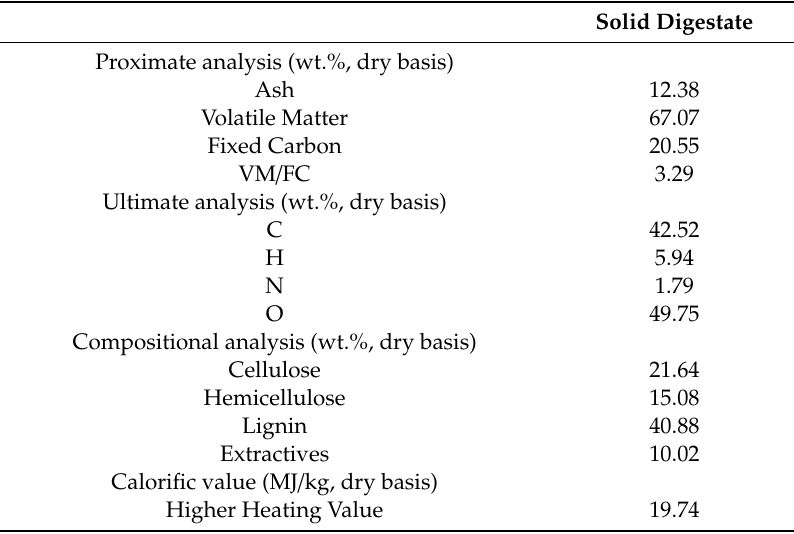
Table 3. Characterization of the digestate sample